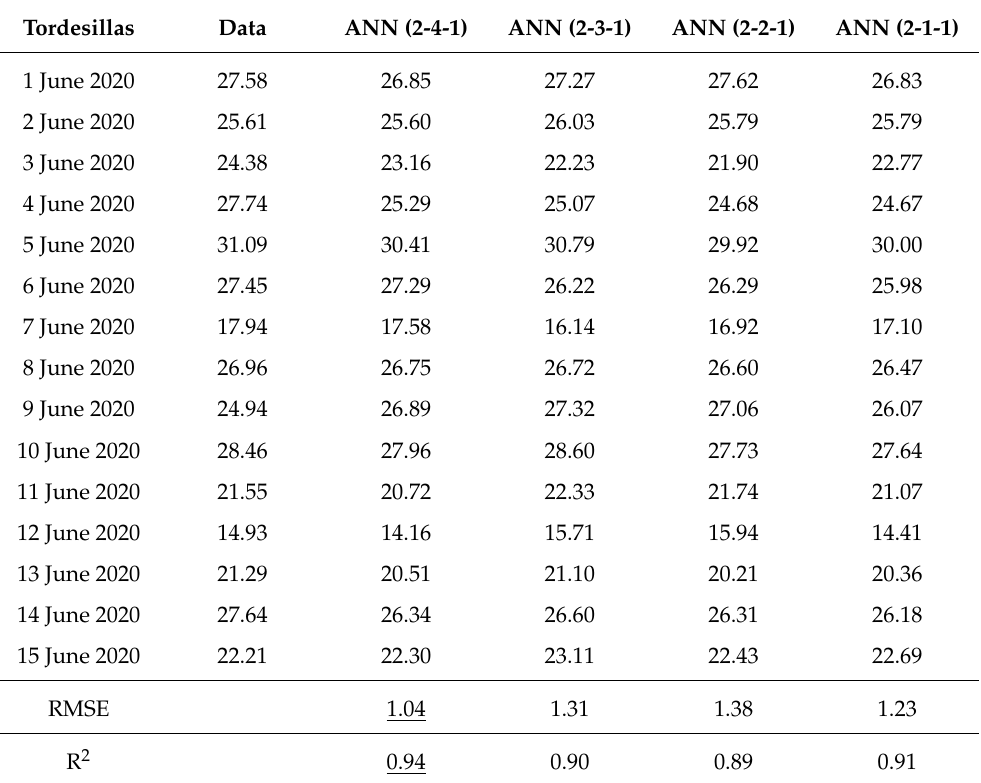
Table 1. Daily global solar irradiation (MJ/m 2 ) in Tordesillas (Valladolid) measured for 15 days (i.e., 1–15 June 2020), estimated with the neural architectures varying the number of neurons from four to one in the hidden layer (i.e., ANN (2-4-1), ANN (2-3-1), ANN (2-2-1) and ANN (2-1-1)), and fitting of the statistics. Tordesillas